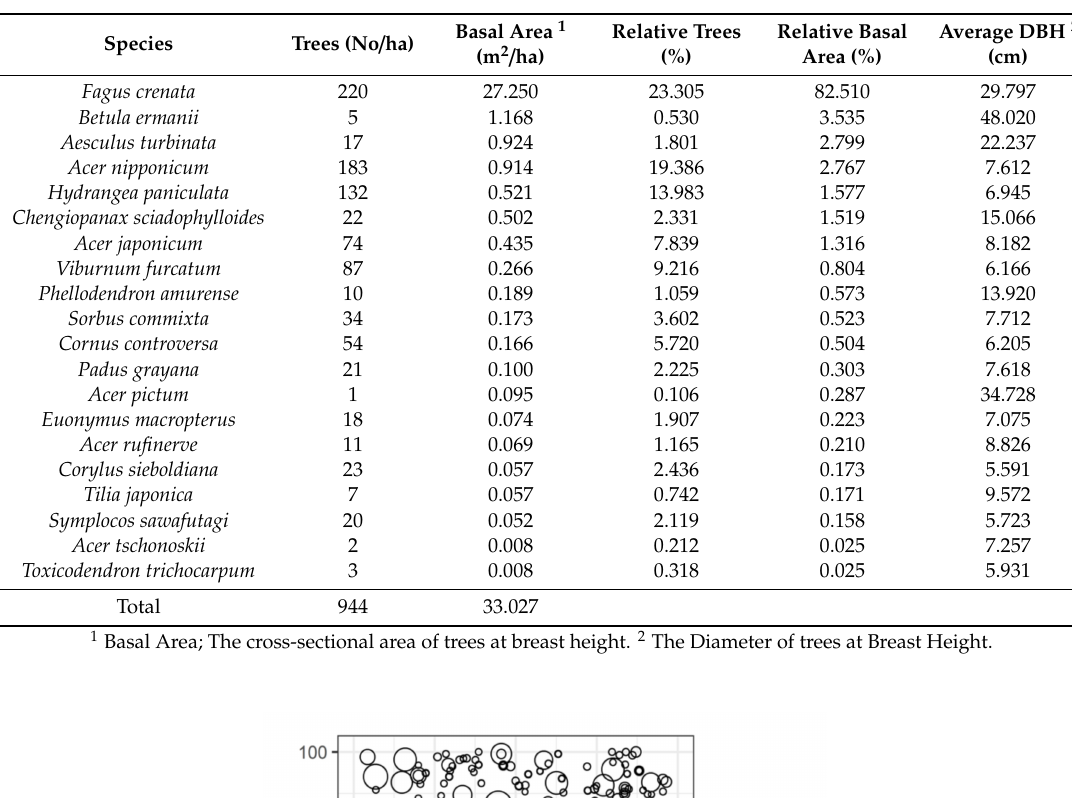
Table 1. Summary of stand characteristics.